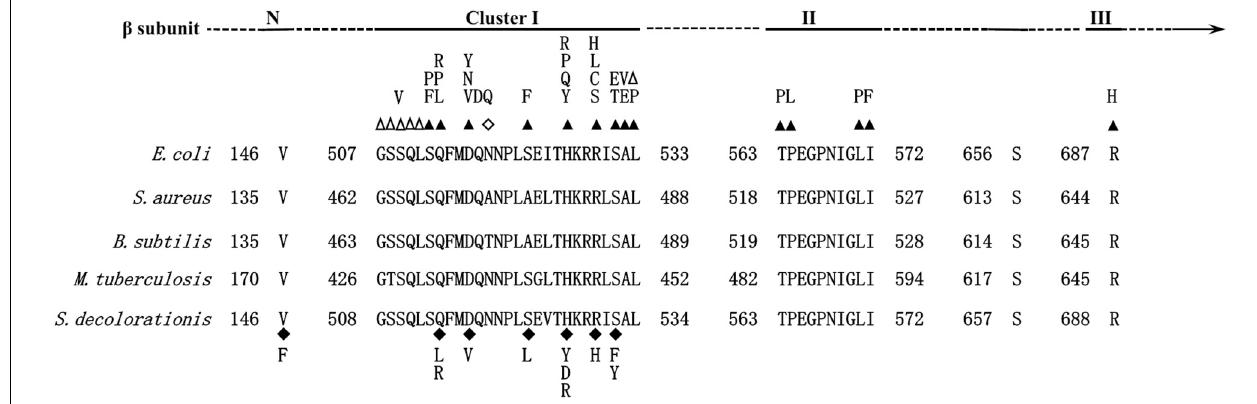
Frontiers in Microbiology |